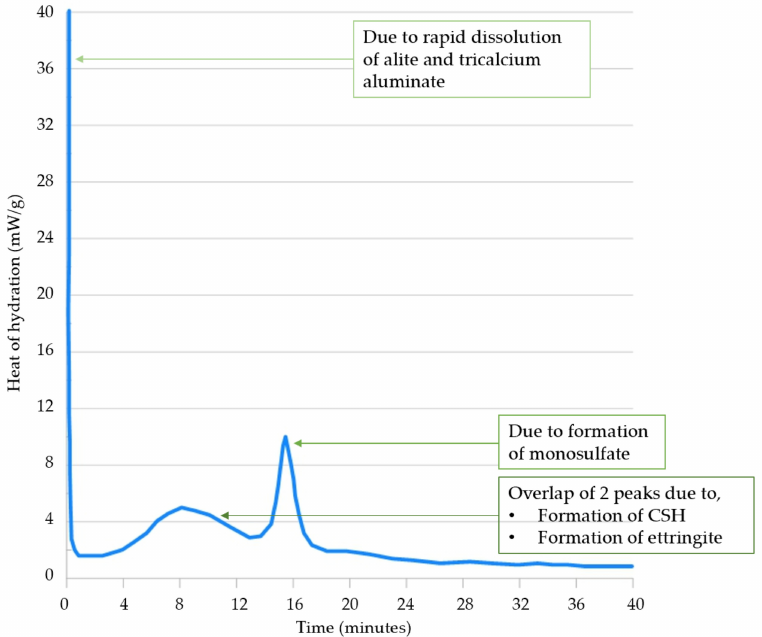
Figure 6. Overall rate of hydration of a properly sulfated system (modified from